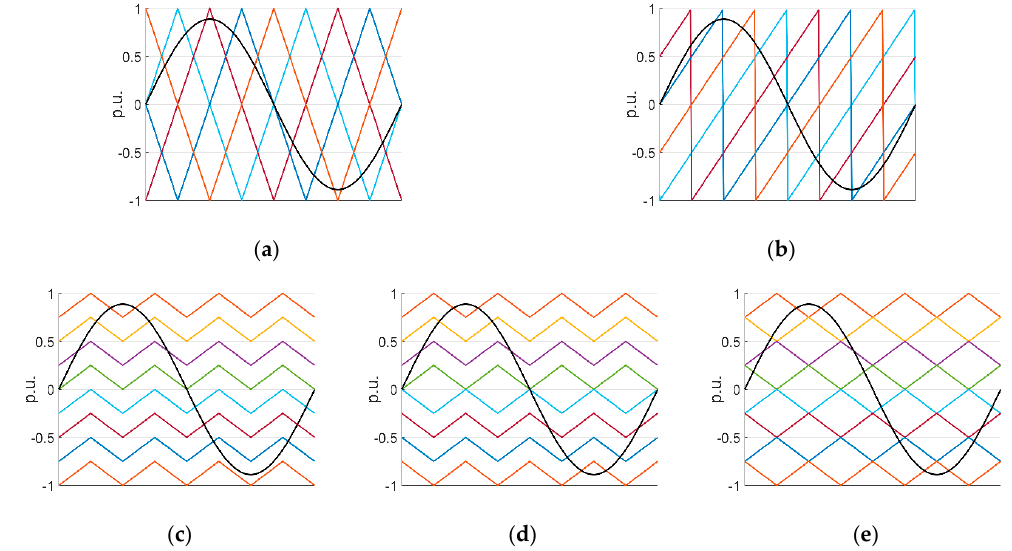
Figure 16. High switching frequency pulse width modulation (PWM) techniques: ( a ) phase-shifted carrier-based pulse width modulation (PSC-PWM) with triangular carriers; ( b ) PSC-PWM with sawtooth carriers; ( c ) phase-disposition pulse width modulation (PD-PWM); ( d ) phase-opposition-disposition pulse width modulation (POD-PWM); ( e ) POD-PWM.